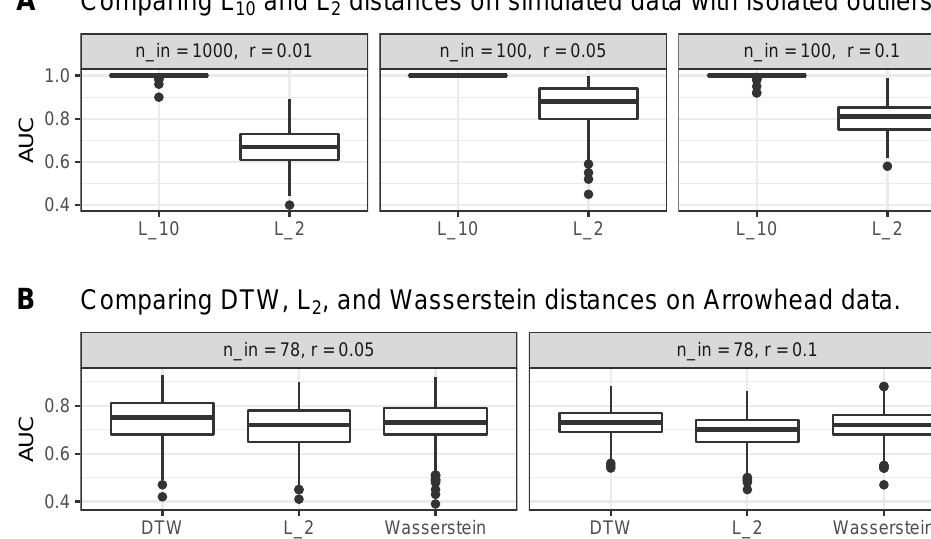
Figure 10. Comparing the effects of different distance measures. Depicted are the distributions of the AUC over 500 replications for the LOF based on MDS embeddings computed with the respective distance measures for different outlier ratios r . ( A ) Comparing the L 10 and L 2 metrics on a dataset with isolated outliers generated via Simulation Model 2 from the package fdaoutlier. ( B ) Comparing the DTW, L 2 , and unnormalized L 1 -Wasserstein distance measures on the real dataset ArrowHead. Note: the DTW distance is not a